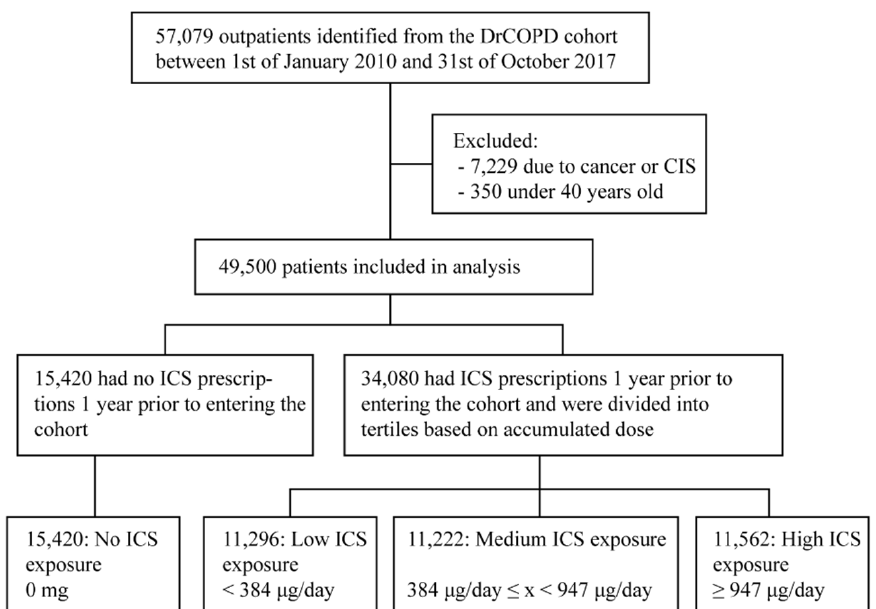
Table 1. There were significant differences between the four groups. Patients receiving higher doses were more likely to be female, have lower BMI, higher MRC score, lower FEV1 and more frequent exacerbations. The frequencies of Charlson comorbidities were evenly distributed in all groups except for asthma, which was more common in patients receiving higher doses of ICS (Table 1). The frequency of alcohol use disorders or other substance abuse disorders was similar in all groups (Table 1).